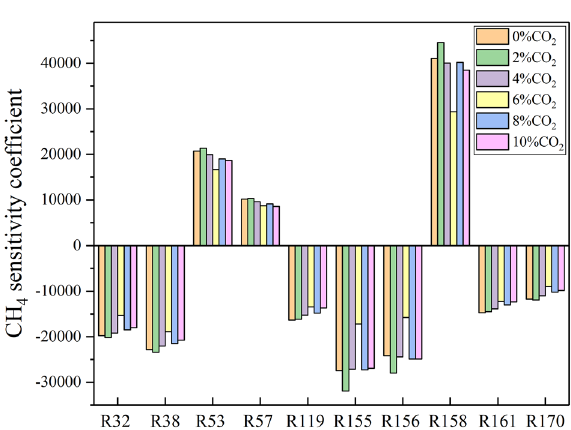
Figure 6. Key reaction steps affecting the change of CH 4 mole fraction: ( a ) 7%CH 4 0%CO 2 , ( b ) 7%CH 4 10%CO